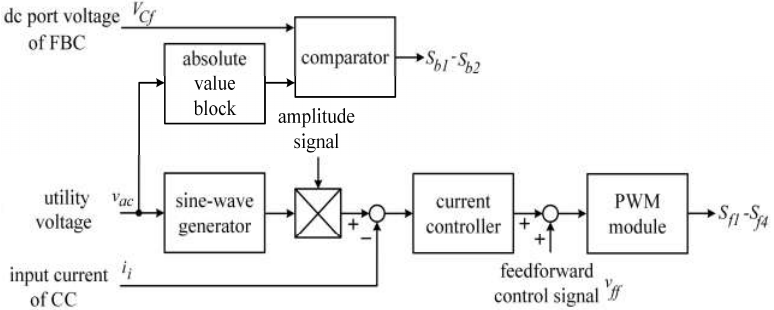
Figure 9. Control block of the CC. Table 1. Circuit parameters of prototype.